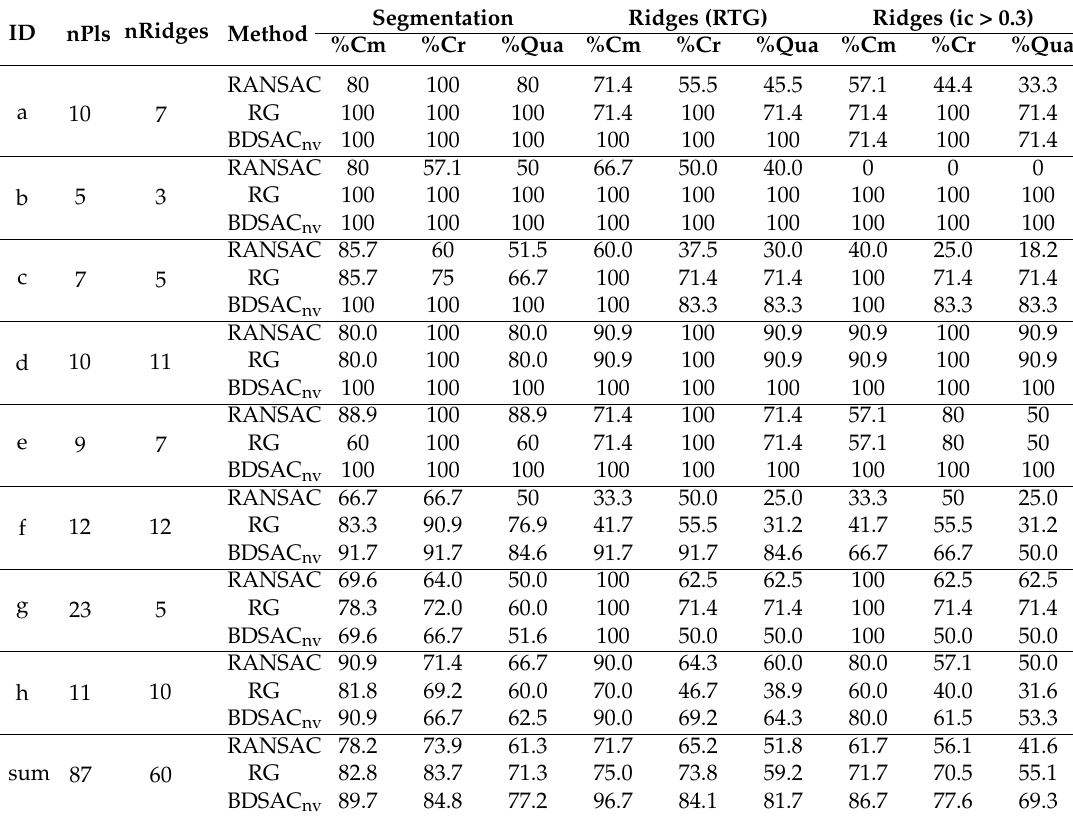
Table 3. Quality of segmentation results for data in Figure